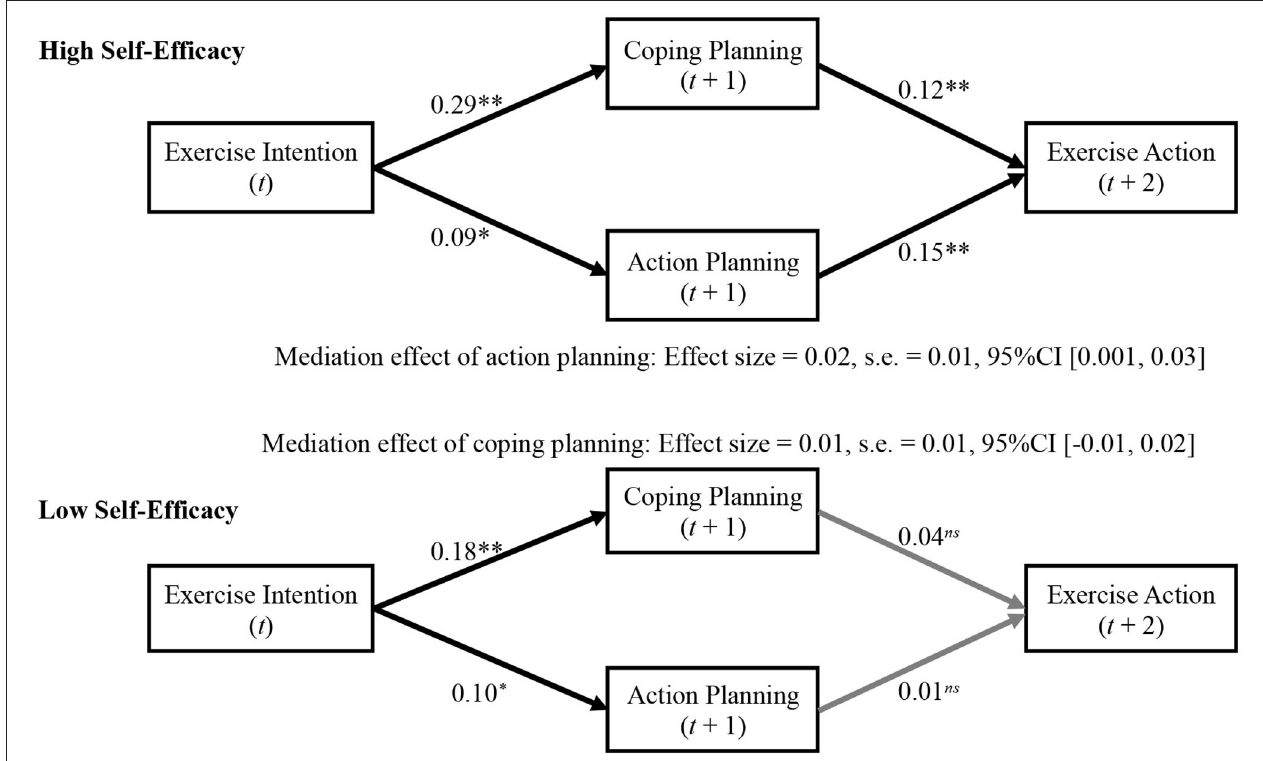
FIGURE 4 | The results of moderated mediation model. Note: * p < 0.05, ** p < 0.01; t , t + 1, and t + 2 indicate that the independent variables were measured at time t , the mediators were measured at lagged time t + 1, and the dependent variable measured at lagged time t +